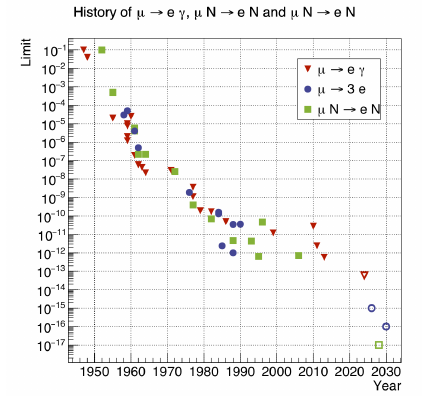
Figure 1. The history of limits for the cLFV golden channels branching ratios. The open markers indicate projected sensitivities. Plot modified from [8].